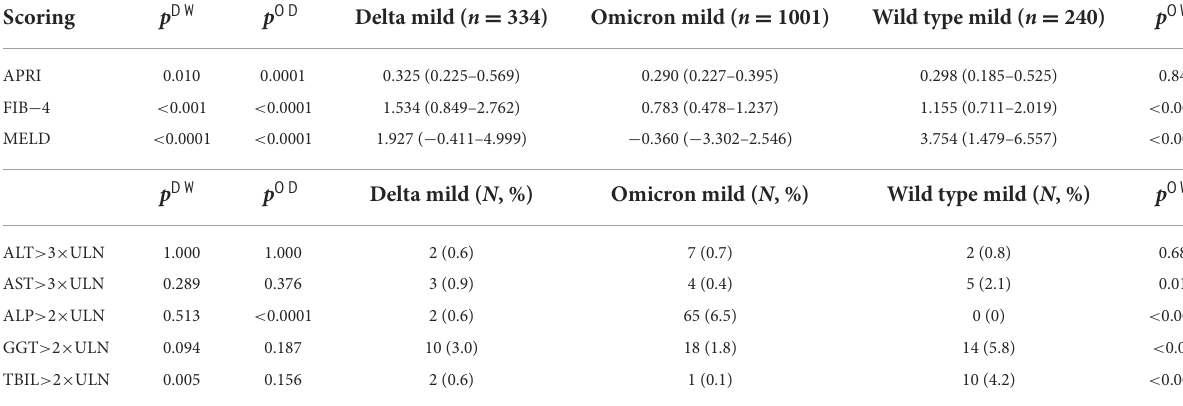
TABLE 3 Scoring systems that are conventionally evaluated for advanced liver diseases, including AST to platelet ratio index (APRI), Fibrosis-4 (FIB-4), and Model for End-stage Liver Disease (MELD), or raised AST/ALT values greater than three times of the upper limit of the normal (ULN), or elevated ALP/GGT/total bilirubin (TBIL) values greater than two times of the ULN, were compared between patients with the omicron variant infection and patients with the delta variant infection (exhibited by p OD values), or between patients with the omicron variant infection and patients with the wild-type SARS-CoV-2 infection (exhibited by p OW values), or between patients with the delta variant infection and patients with the wild-type SARS-CoV-2 infection (exhibited by p DW